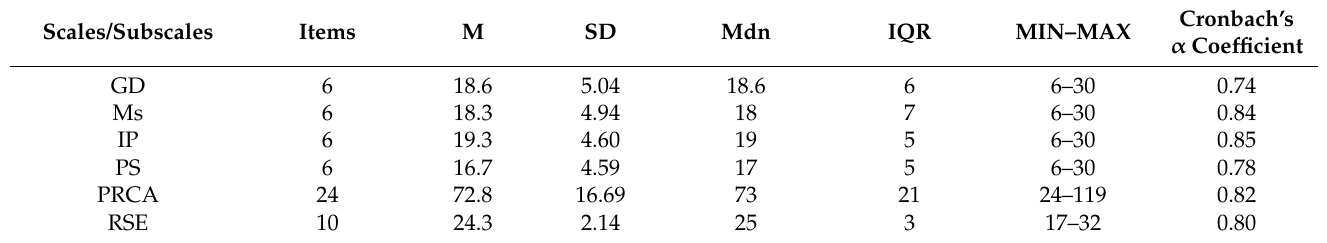
Table 2. Descriptive and Internal consistency of the Self-esteem and Communication apprehension and its subscales.